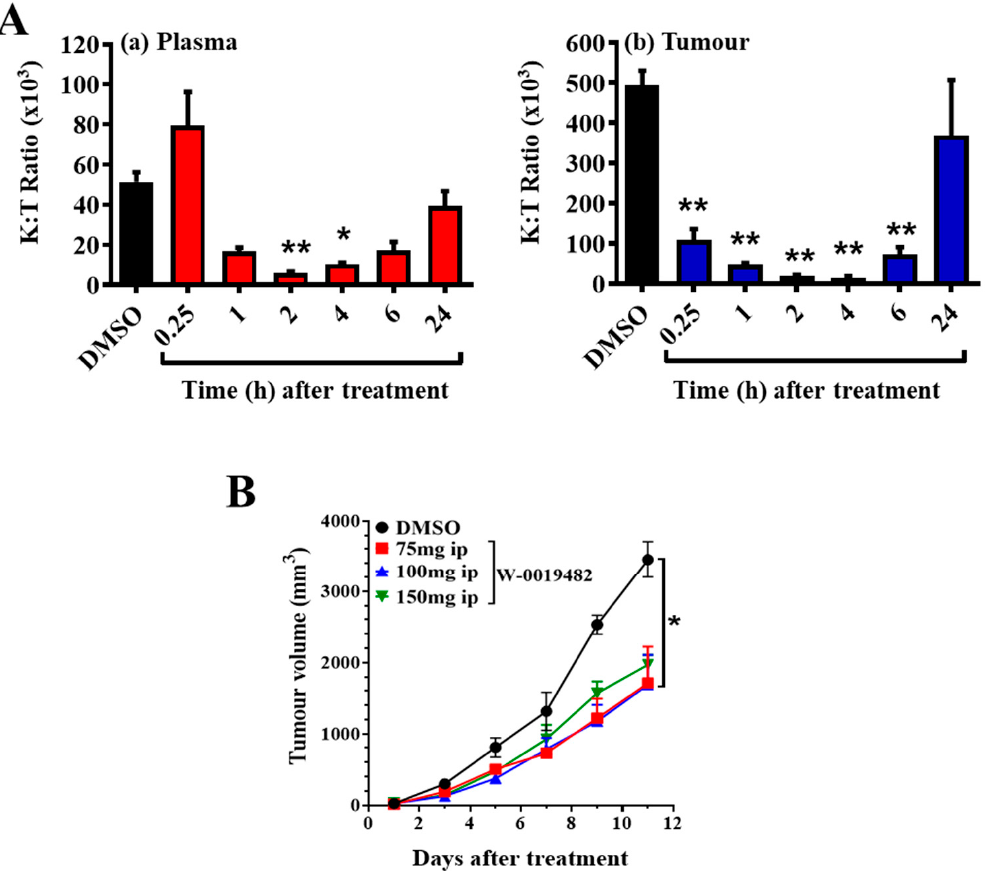
Figure 5. ( A ) K:T ratios at indicated times following treatment with W-0019482 (150 mg/kg) collected from mice with 16-day GL261-hIDO1 tumours (15–20 mm in size), in (a) plasma (red) and (b) tumours (blue). Bars represent mean ± s.e.m. of 3 mice per time point. DMSO vehicle control (black), bar represents mean ± s.e.m. from 21 samples pooled from 3 mice per timepoint following treatment with DMSO. * and ** denote significance ( p < 0.05, p <0.01, respectively) by one-way ANOVA and Sidak’s multiple comparisons compared to DMSO controls. ( B ) Growth of subcutaneous GL261-hIDO1 tumours following daily ip injection of W-0019482 at 75 mg/kg (red squares), 100 mg/kg (blue triangles), and 150 mg/kg (green) compared to DMSO vehicle controls (black). * denotes significant difference ( p < 0.05) between treated and vehicle controls by two-way ANOVA and Tukey’s multiple comparisons .